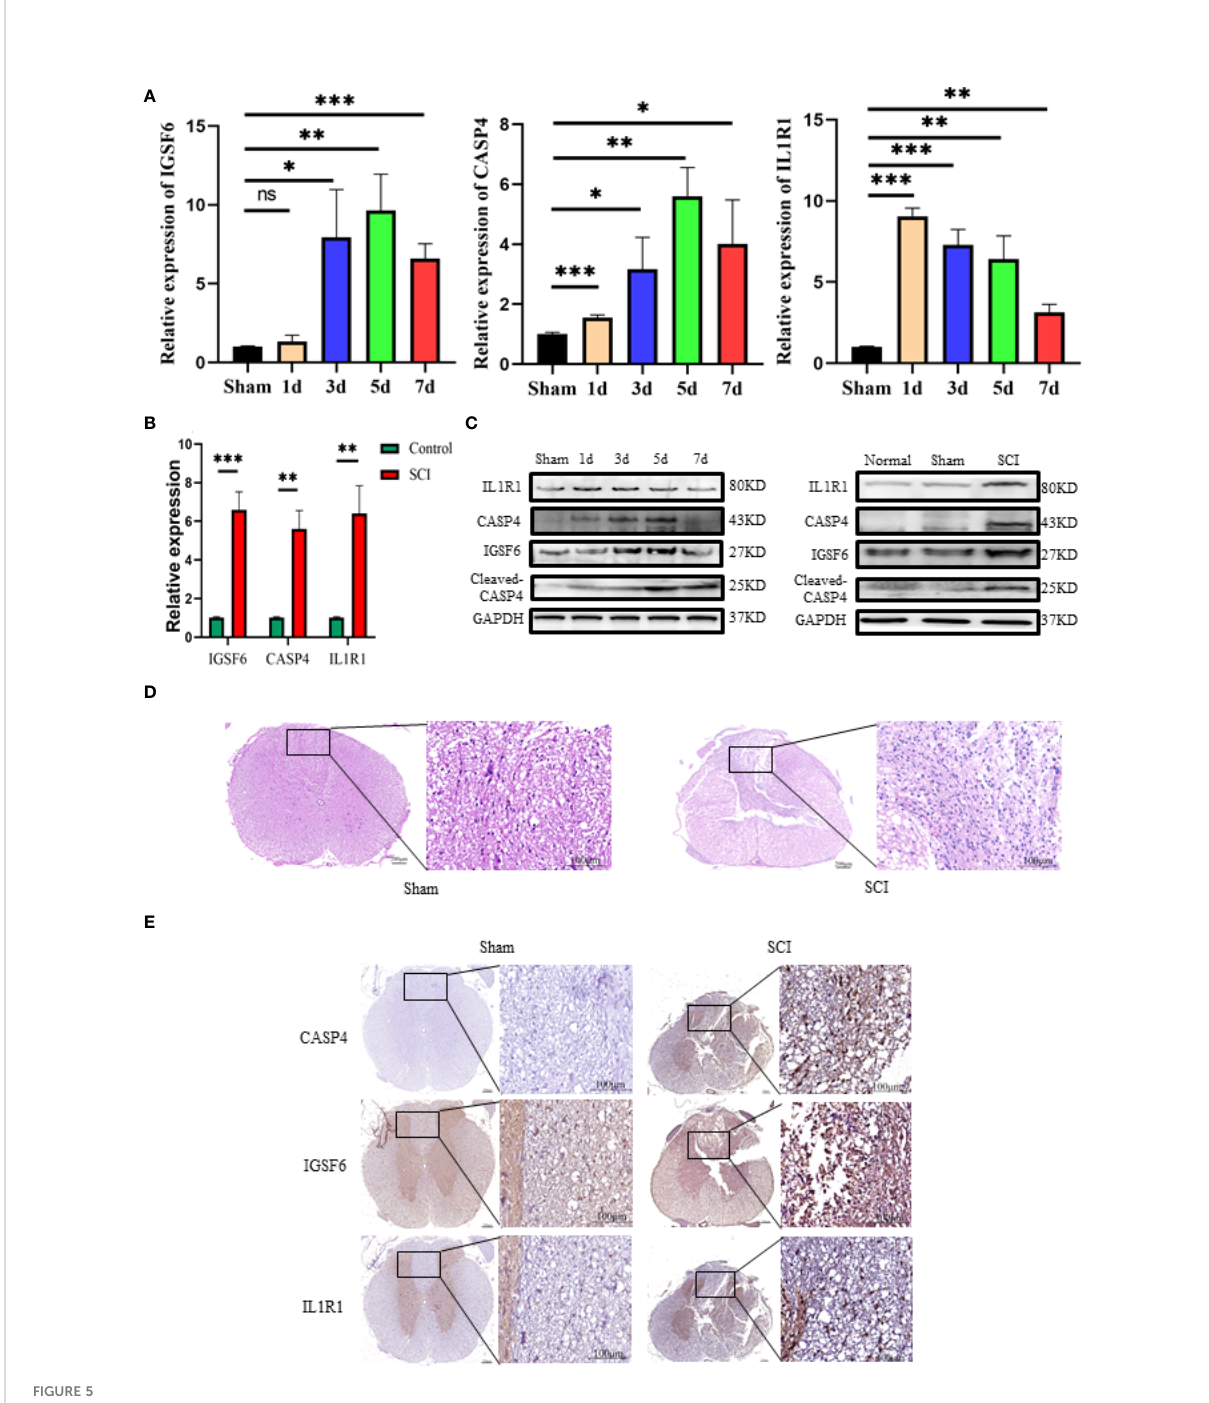
FIGURE 5 Western blot, RT-qPCR and immunohistochemistry of the three biomarkers (IL1R1, CASP4 and IGSF6). (A) The time curves of the three biomarkers at mRNA level on day 1, 3, 5 and 7 after SCI or sham surgery (n = 3 rats per group at each time point, values are the mean ± SD, *p < 0.05, **p < 0.01, ***p < 0.001, t-test). (B) RT-qPCR validation of the biomarkers expressing in peak: the three signatures were increased signi fi cantly in SCI group (n = 3 rats per group, values are the mean ± SD, *p < 0.05, **p < 0.01, ***p < 0.001, t-test). (C) Western blot validation of the biomarkers as represented by their time curves at protein level (n = 3 rats per group, values are the mean ± SD, *p < 0.05, t-test). (D) Histomorphologically, the injured spinal cord tissue exhibited organizational abnormalities as compared with the normal control (overall scale bars = 200 m m, regional-scale bars = 100 m m). (E) Immunohistochemical validation of the biomarkers: the markers were found to be expressed in both gray matter and white matter (Overall scale bars = 200 m m, regional-scale bars = 100 m m, the arrows point to the positioning of the